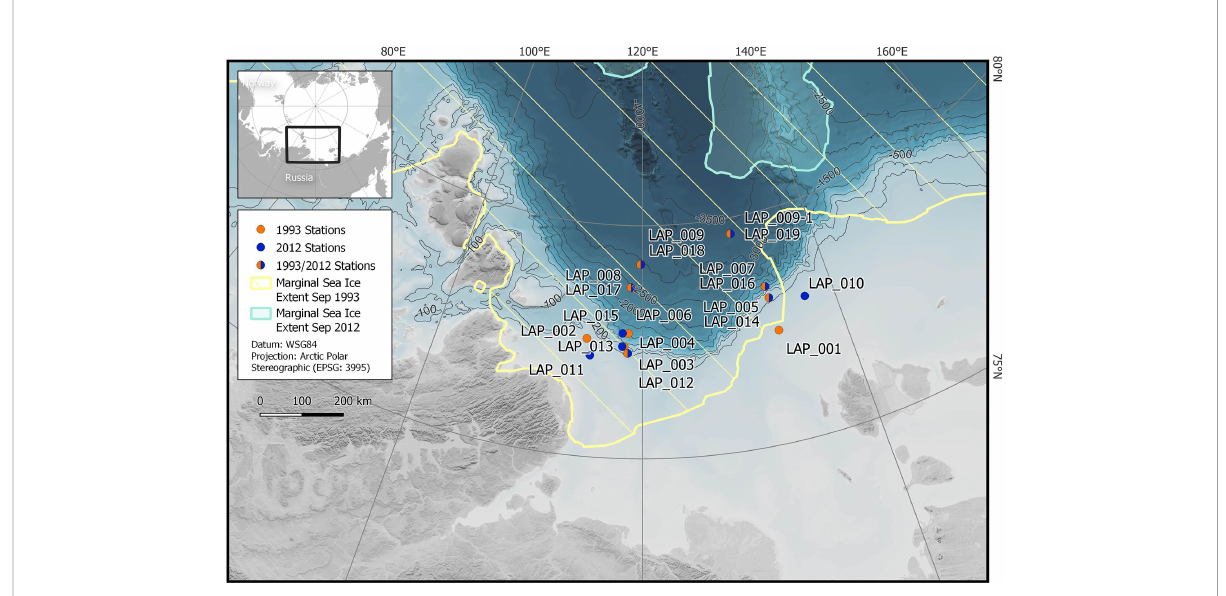
FIGURE 1 Sampling locations on the Laptev Sea continental slope. The same stations were targeted in 1993 and 2012; sampling took place in August/ September (see Table 1 for exact positions and sampling dates). While the Laptev Sea was largely ice-covered throughout the year in 1993, the entire sampling area was ice-free in 2012. The marginal sea ice extent is indicated in yellow (1993) and blue (2012).